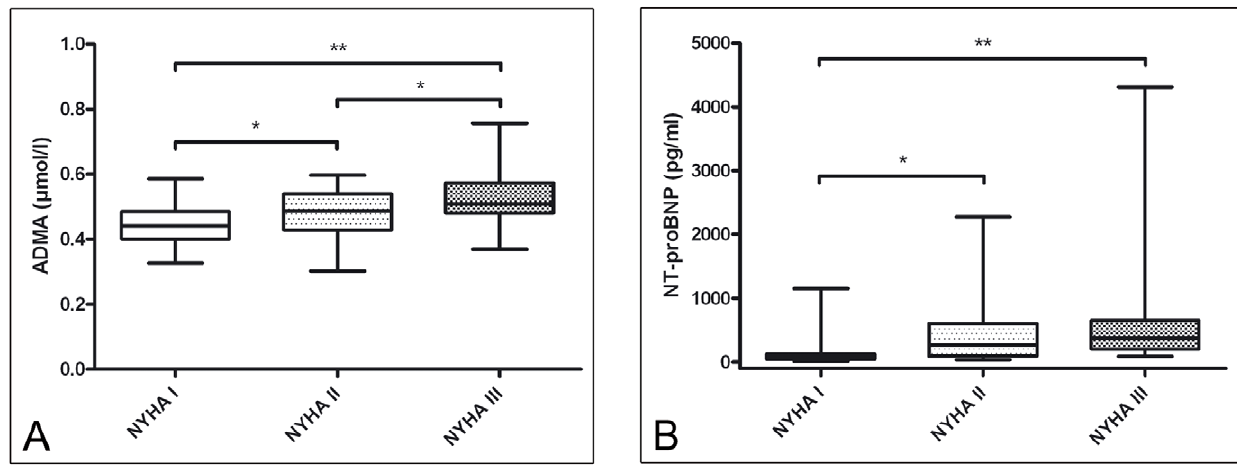
Figure 1. ADMA and NT-proBNP in comparison between NYHA classes. (* p , 0.05, ** p , 0.001)